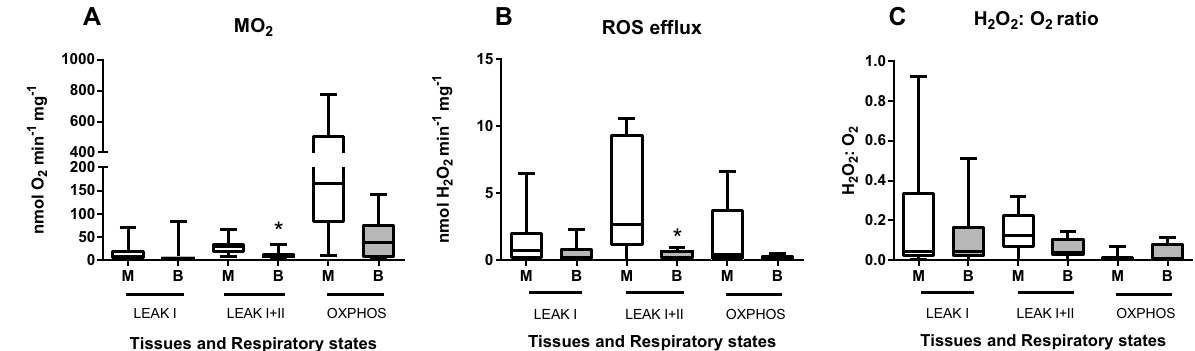
Figure 1. Baseline mitochondrial oxygen consumption ( Ṁ O 2 ) and ROS efflux rates in the permeabilized skeletal muscle and brain cells of S. scrofa under the control (normoxic) conditions. ( A ) oxygen consumption rates, ( B ) ROS efflux rates, ( C ) electron leak (the ratio of H 2 O 2 produced to O 2 consumed by the permeabilized cells). Tissues: M—skeletal muscle cells, B—brain cells. Mitochondrial traits were measured in non- phosphorylating mitochondria in the presence of Complex I substrates (LEAK I), the mixture of Complex I and II substrates (LEAKI+II), and in the phosphorylating (ADP-stimulated) mitochondria respiring on the mixture of the Complex I and II substrates (OXPHOS). Asterisks indicate significant differences in the respective traits between different tissues ( P <0.05).